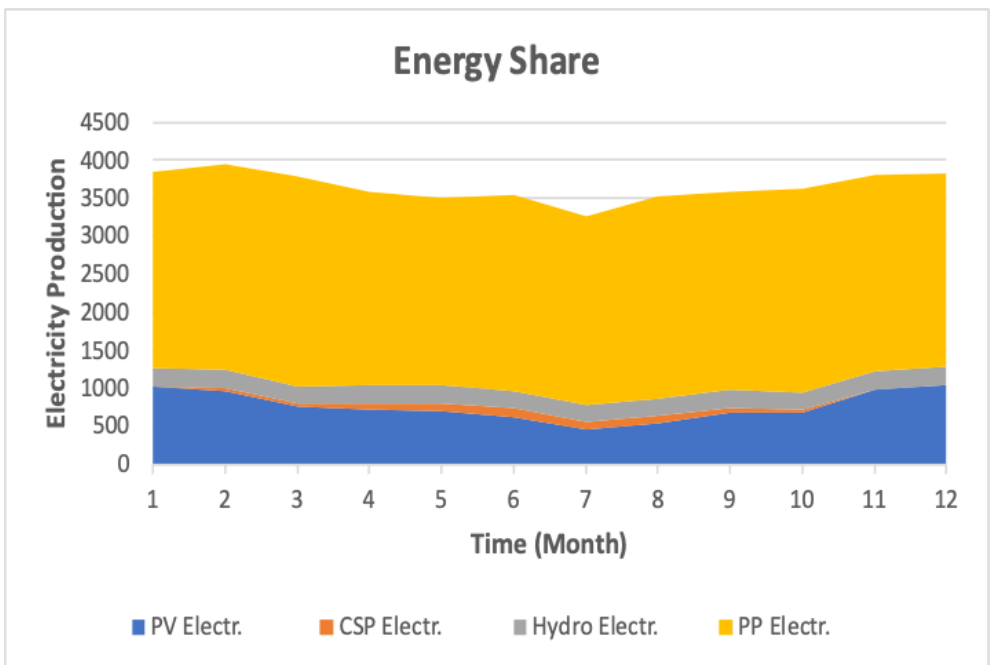
Figure 11. Fluctuations in the monthly energy share for several renewable energy sources in the UAE. Table 14. Total annual electricity production required for the achievement of the 2030 goal of utilizing renewable energy sources to supply 25% of the electricity in the